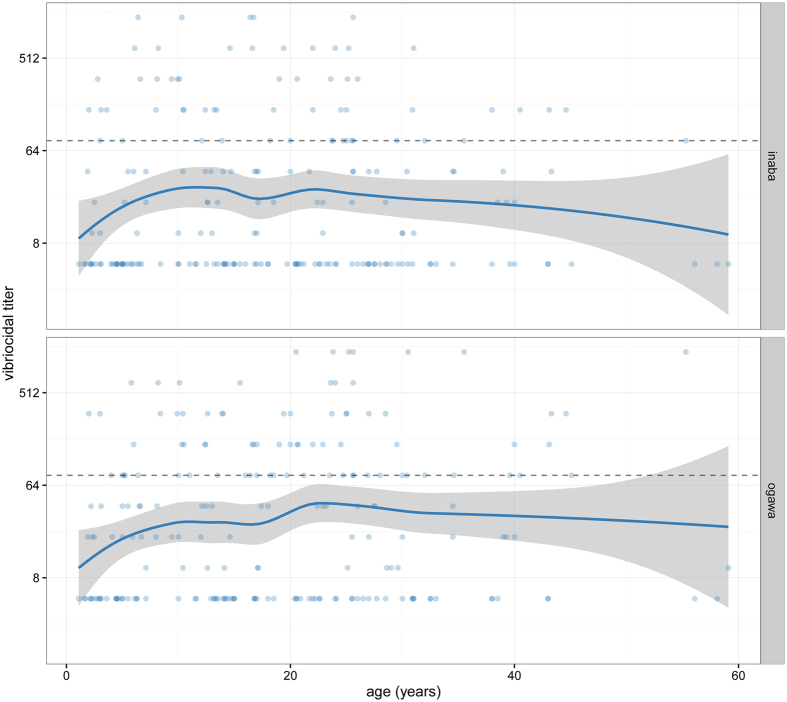
Baseline Inaba and Ogawa vibriocidal titers (y-axis, log2 transformed) by age (x-axis).Dots represent individual data points, with blue line representing smoothed (lowess) model with 95% confidence intervals in grey.